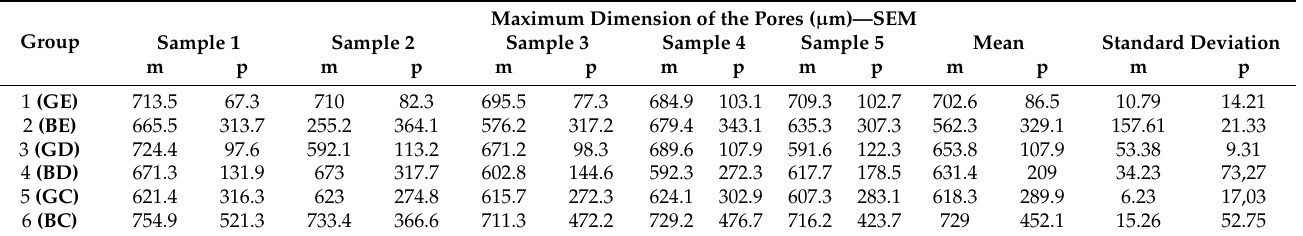
Table 2. Ascertainment of the maximum dimension of the pores ( µ m) on SEM images for the two investigated areas, median (m) and peripheral